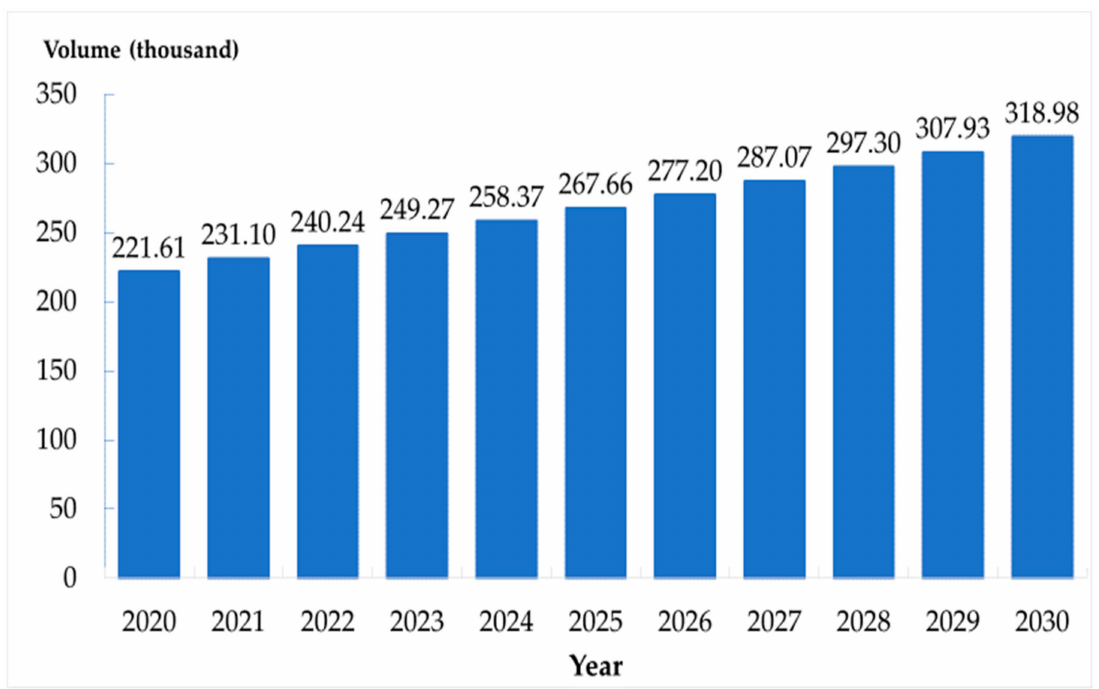
Figure 2. Number of the elderly in social group in Thailand, 2020–2030.